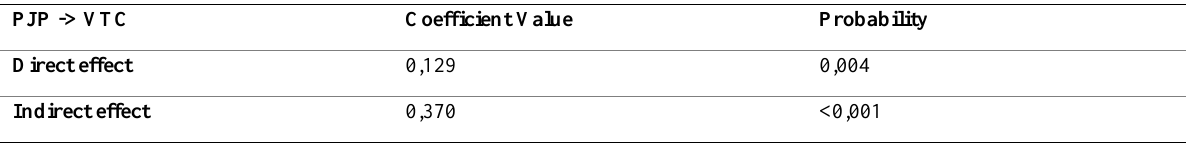
Table 5: Coefficient and probability